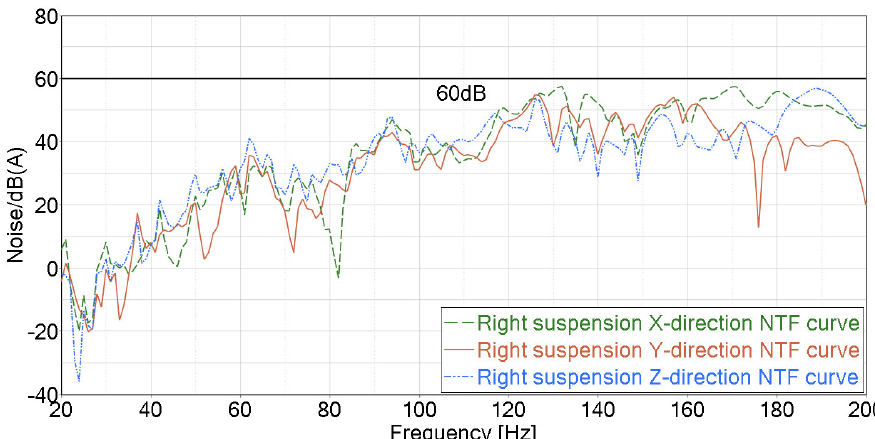
Figure 9. Right engine suspension noise transfer function